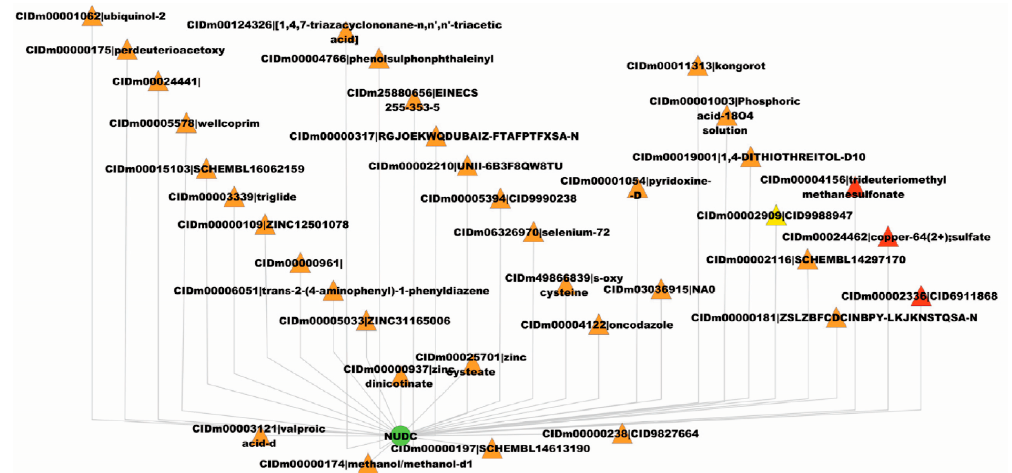
Figure 3. The known and predicted novel drugs that target the gene, NUDC . The yellow triangles denote the known drugs, the red triangles denote the predicted novel drugs and the green circle denotes the concerned gene NUDC .